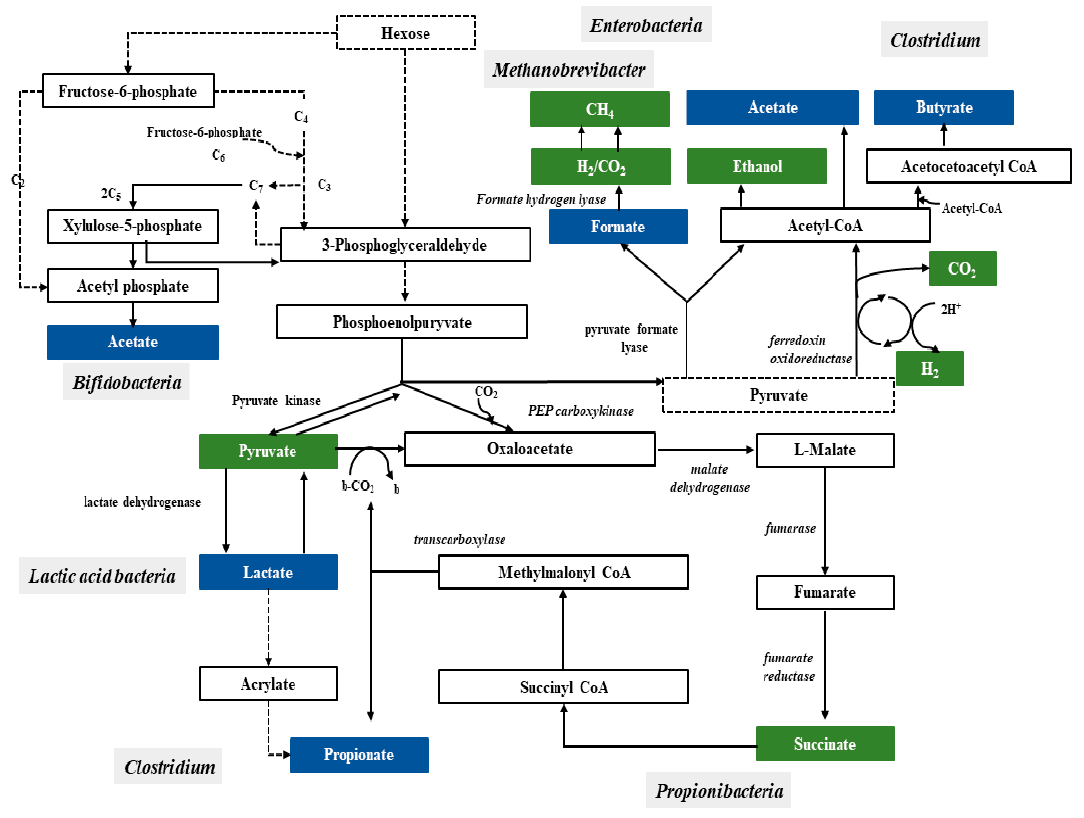
Figure 1. Pathways leading to SCFAs and lactic acid production by intestinal bacteria [48].